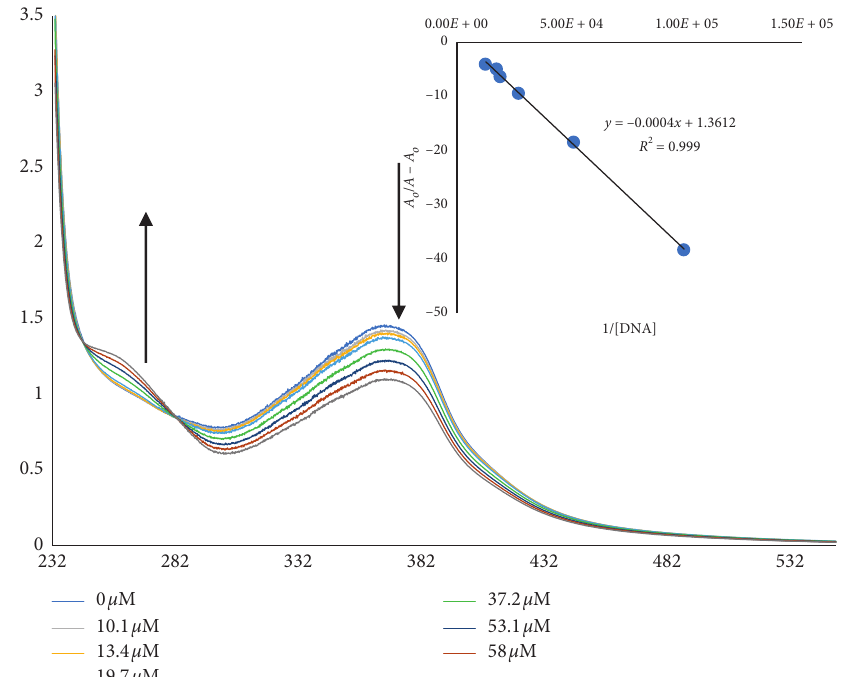
Figure 11: UV-visible absorption spectra for the C2 at 18 µ M without CT-DNA and with serial addition of DNA. Inset is the Bene- si–Hildebrand plots for the determination of binding constant.